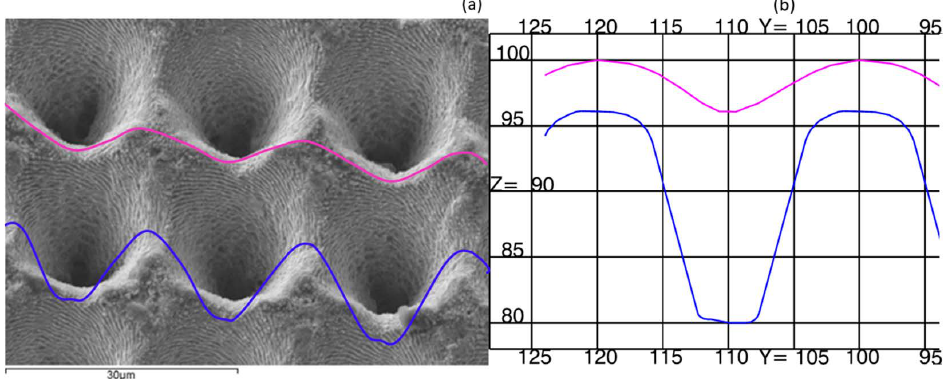
Figure 2. ( a ) SEM micrograph of micro-holes of the mold and ( b ) detailed CAD sections.